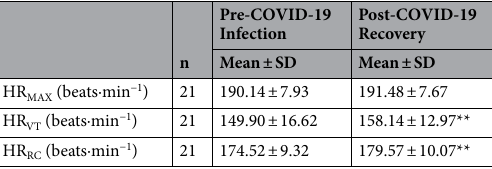
Table 6. Maximal heart rate (HR MAX ) and heart rate at VT (HR VT ), and RC (HR RC ). *p < 0.05, **p < 0.01.